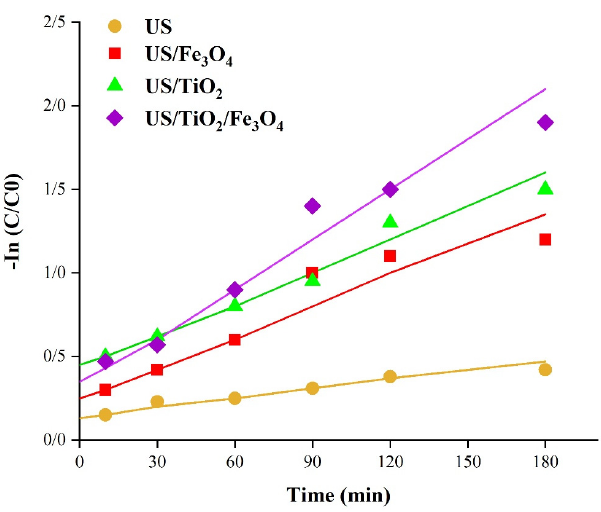
Fig. 6. Analysis of amoxicillin degradation